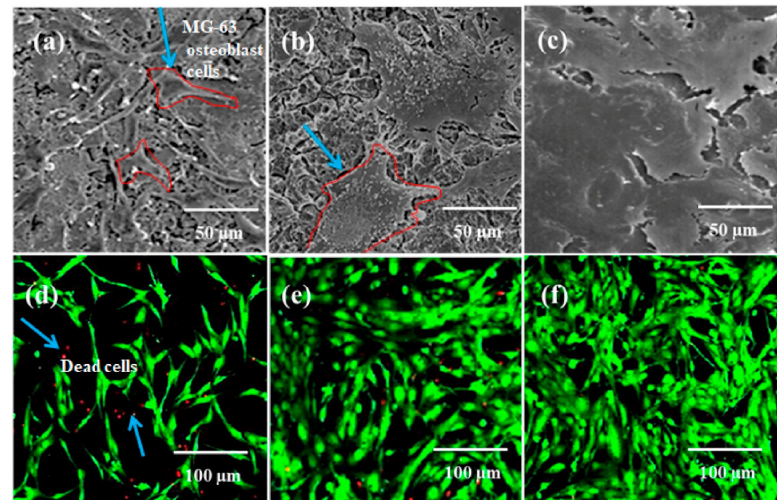
Figure 9. Analysis of cell adhesion and proliferation: ( a – c ) SEM pictures of BCp-PVp/GO 5 wt % electrospun composites after ( a ) 7 days, ( b ) 14 days, and ( c ) 21 days. ( d – f ) Live/dead analysis [212]. Reproduced with permission from Ref. [212]. Copyright 2018 MDPI. Sensors 2022 , 22 , x FOR PEER REVIEW